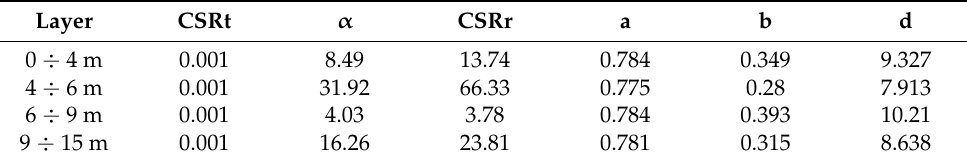
Table 2. Parameters of the pwp model used in the effective stress analyses. Layer CSRt  CSRr